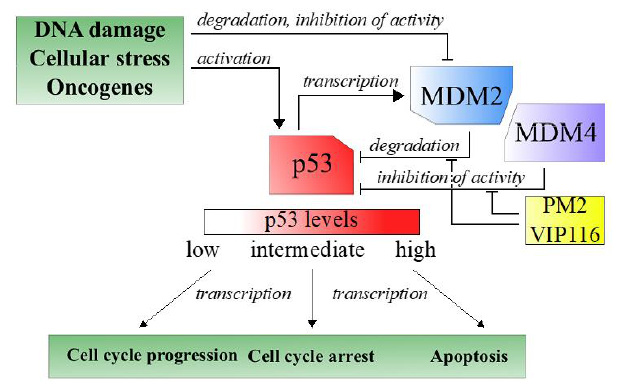
Figure 1. Simplified description of the p53 pathway in response to cellular stress.